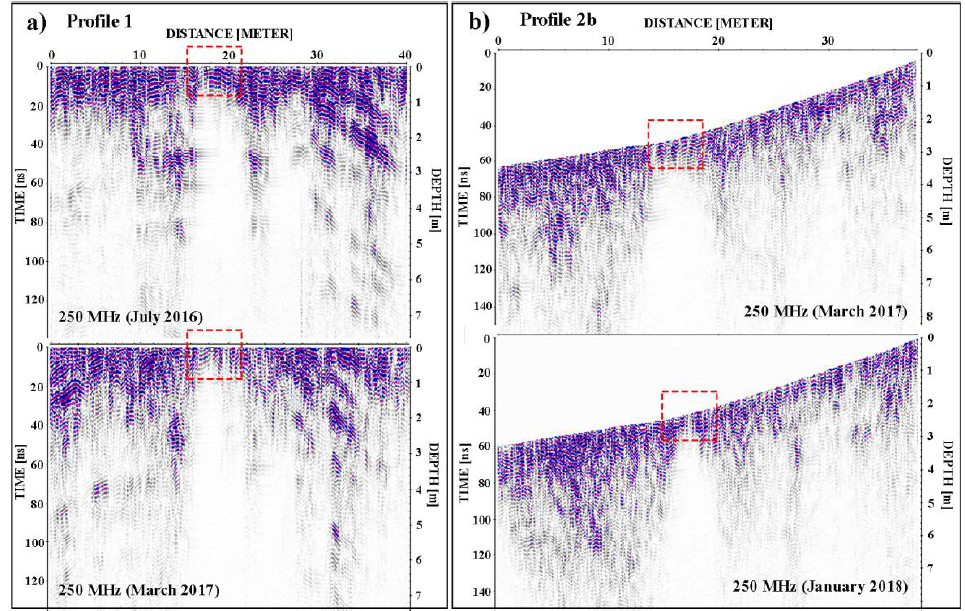
Figure 11. The GPR images obtained in various field conditions using the 250 MHz antenna and the area of cave sediments (dashed red lines): ( a ) Profile 1 acquired in July 2016 (very dry field conditions) and in March 2017 (dry field conditions); ( b ) Profile 2b acquired in March 2017 (dry field conditions) and in January 2018 (moderately wet field conditions).